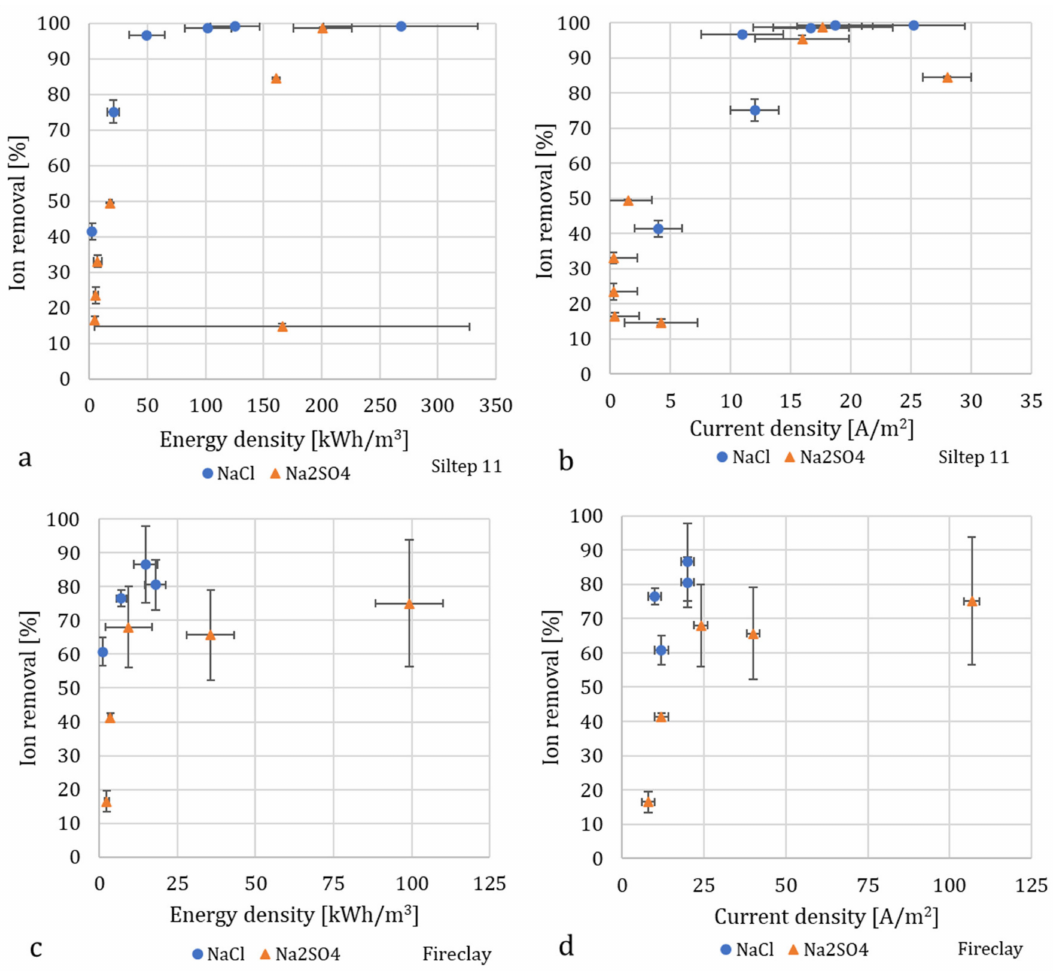
Figure 8. Desalination as a function of energy density and current density for Siltep 11 in ( a , b ), foamed fireclay in ( c , d ), and NaCl and Na 2 SO 4 as electrolytes. The data show inconsistencies, for instance, the high energy density and low desalination for one case in ( a ), which was caused by the high voltage that was necessary to sustain the applied current. This may have been caused by temporary scaling inside the porous material or on membranes. The energy required for pumping is not